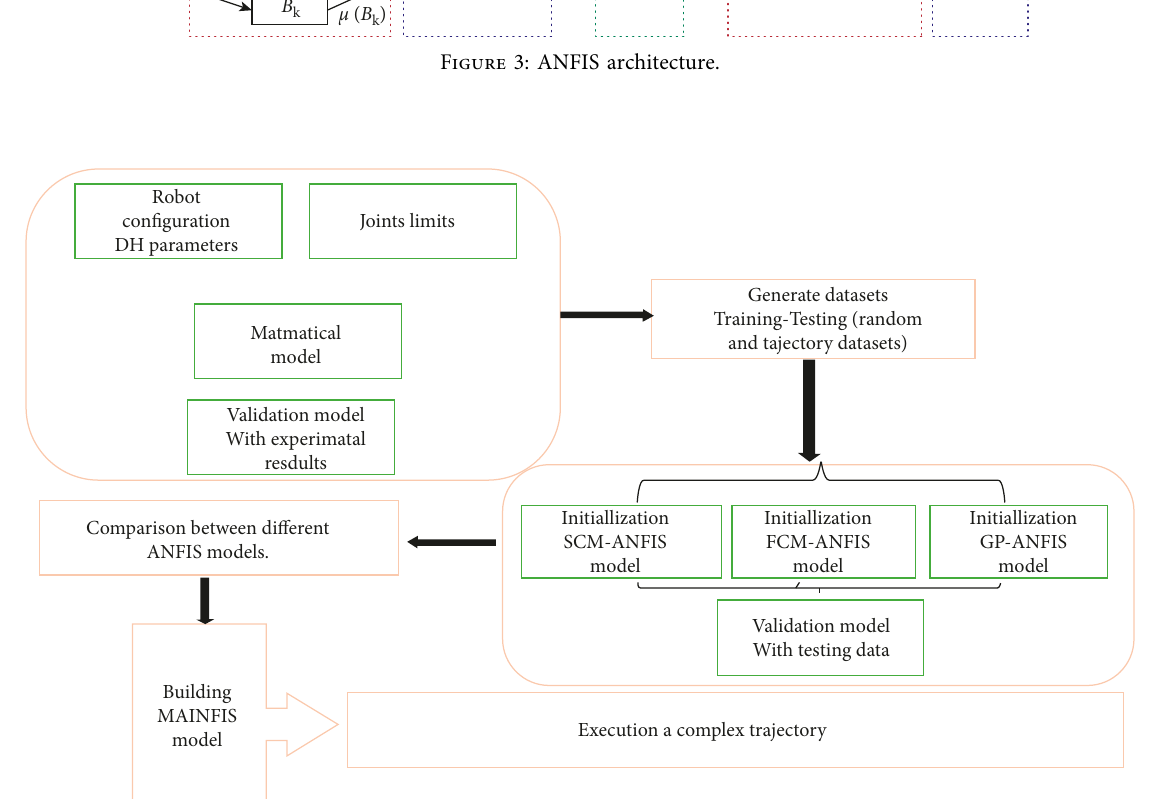
Figure 4: Overview of the work steps.